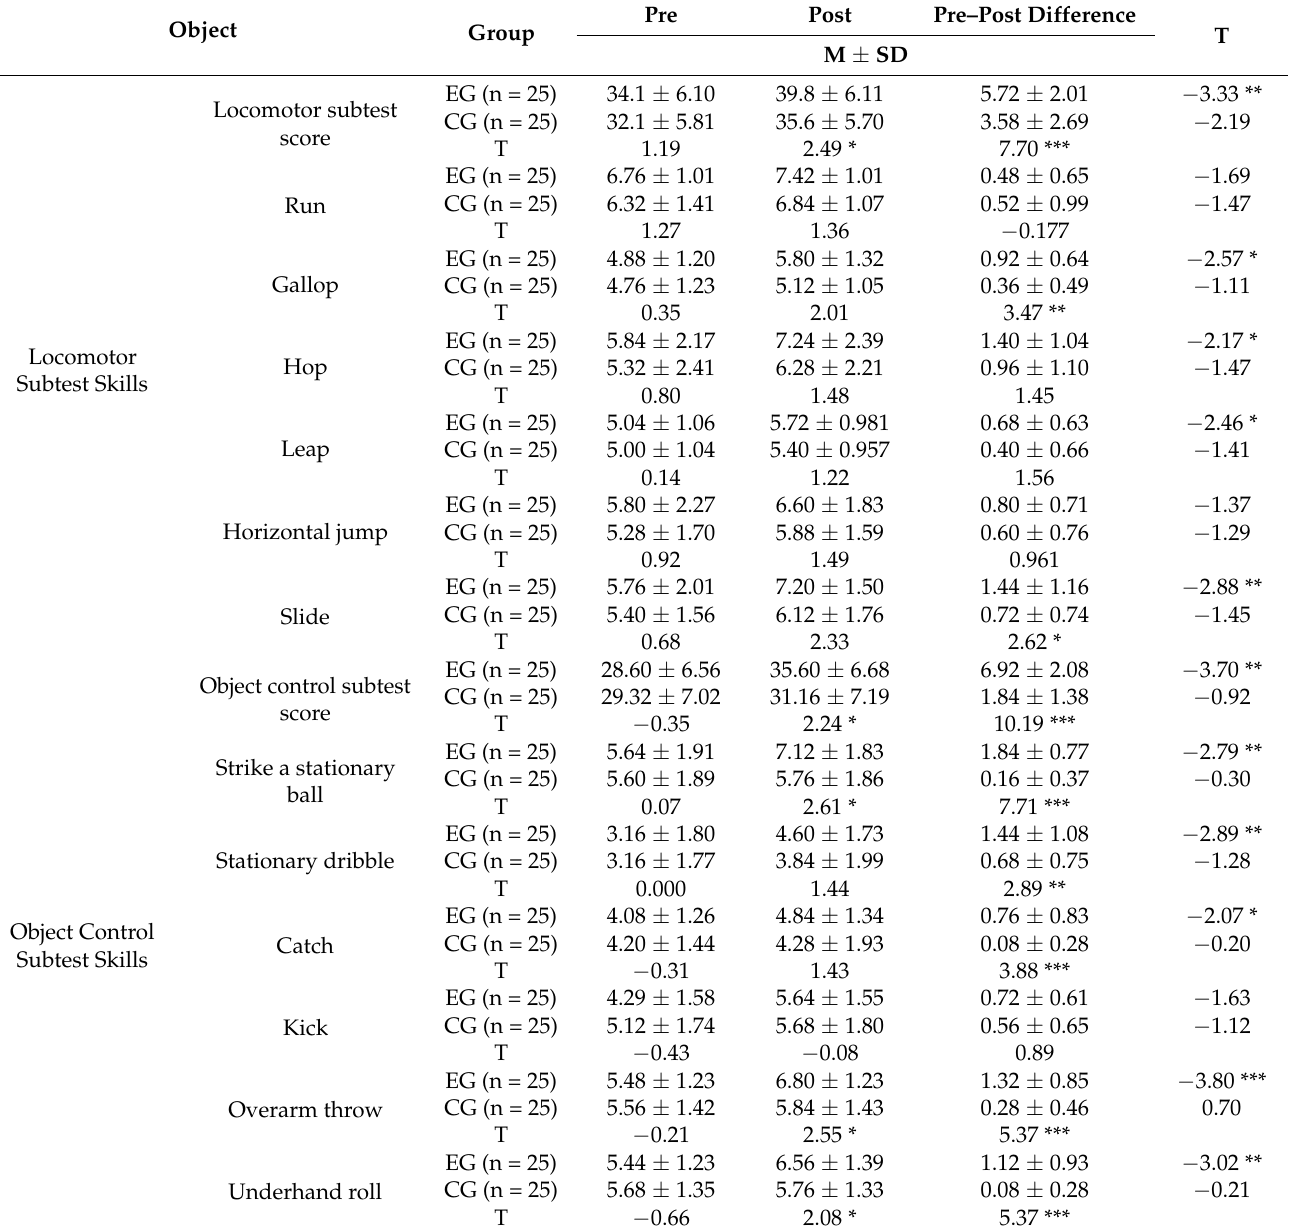
Table 6. Comparison of locomotor subtest skills and object control subtest skills between male EG and CG pre- and post-test